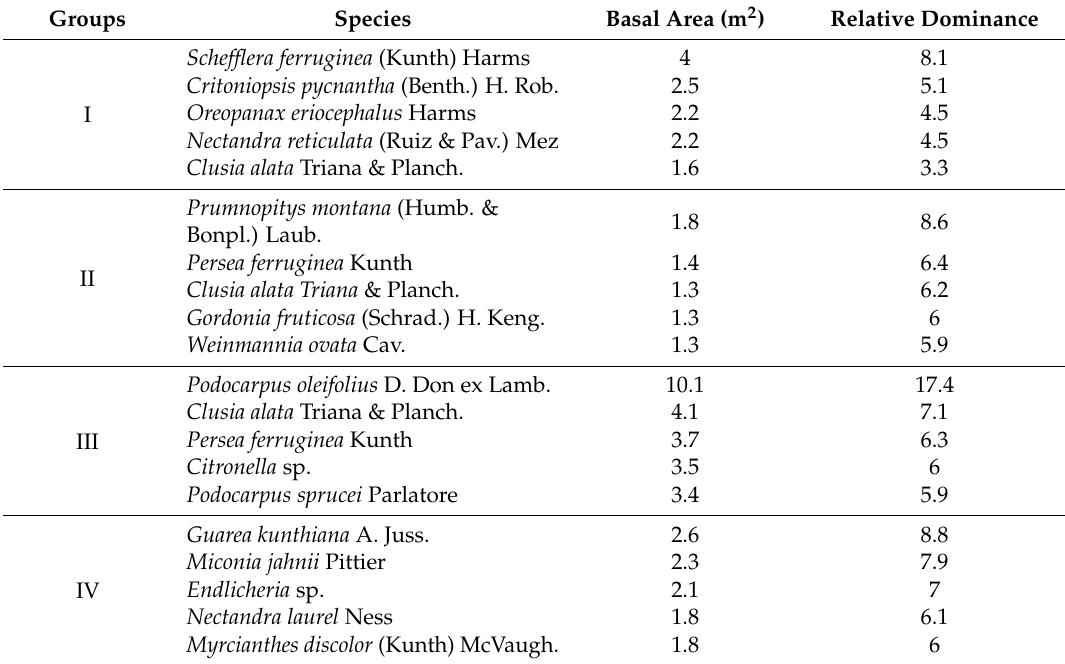
Table 2. Species with greater basal area in each floristic